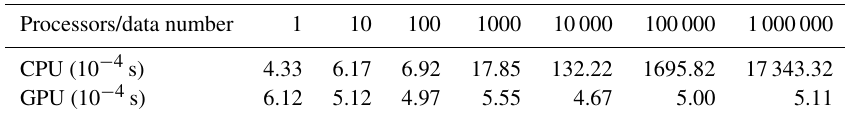
Figure 7. (a) Position information of points A, B, and C and values of alpha, beta, and gamma describing the posture of the end effector. (b) Projected trajectory of a defined curve. (c) Simulation configuration using MATLAB. Table 6. Calculation time of different data amounts using diverse processors.